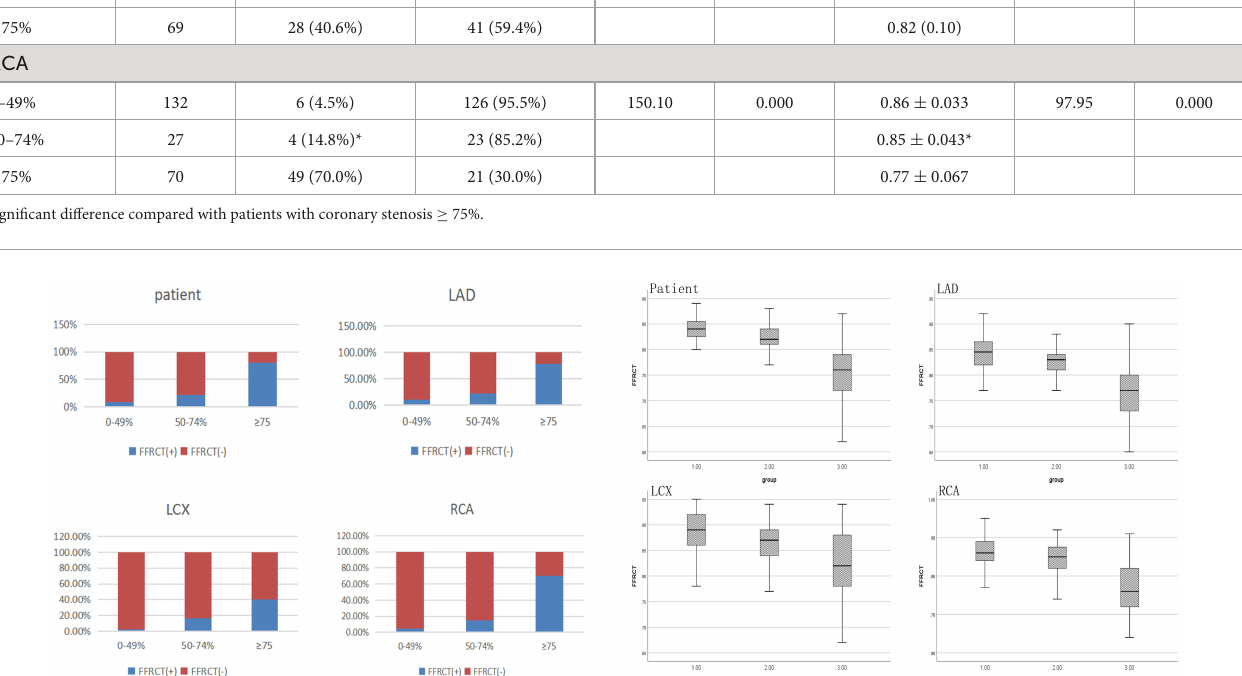
excellent diagnosis performance according to ICA [AUC, 0.86 (95% CI,